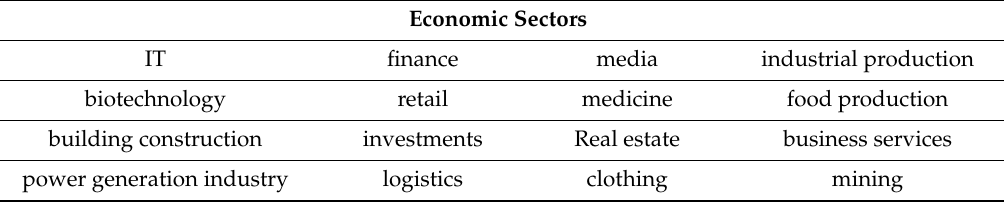
Table 2. General economic sectors defined and included in the